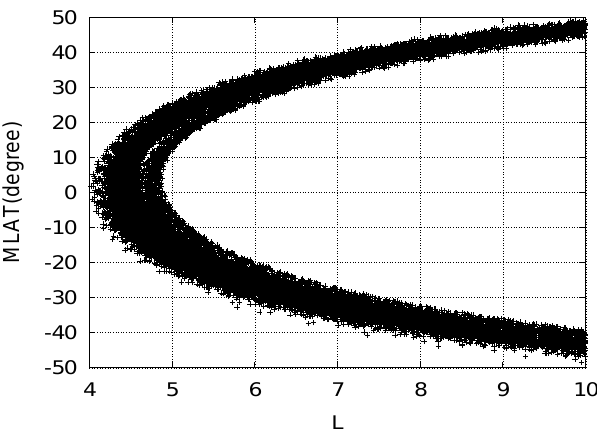
Fig. 1. Relationship between L value and magnetic latitude (MLAT) for our data set. Each data point consists of 5min aver- age values in our database.